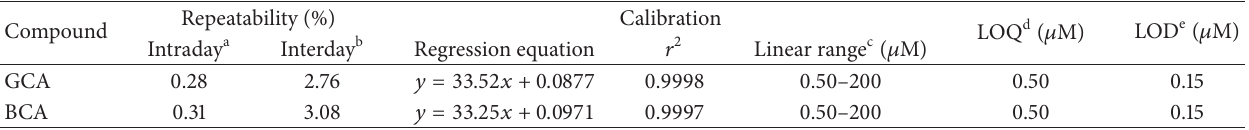
a RSD of peak area based on 8 runs of a solution of the standard over 1 day. b RSD of peak area based on 8 runs of a solution of the standard on independent days. c Concentration range between the limit of quantification and the upper linear limit. d Limit of quantification: signal/noise ratio = 10. e Limit of detection: signal/noise ratio = 3. 𝑦 = concentration ( 𝜇 M). 𝑥 = peak area analyte/peak area internal standard. Table 3: Recovery (mean and RSD) of the HPLC method for determination of GCA and BCA in V. sativa (sample 7 of Table 4). Compound